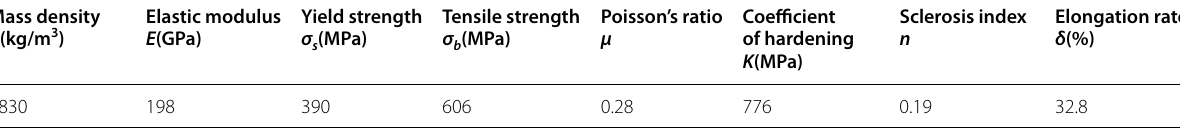
Table 2 Parameters of the SAPH440 steel tube Mass density ρ (kg/m 3